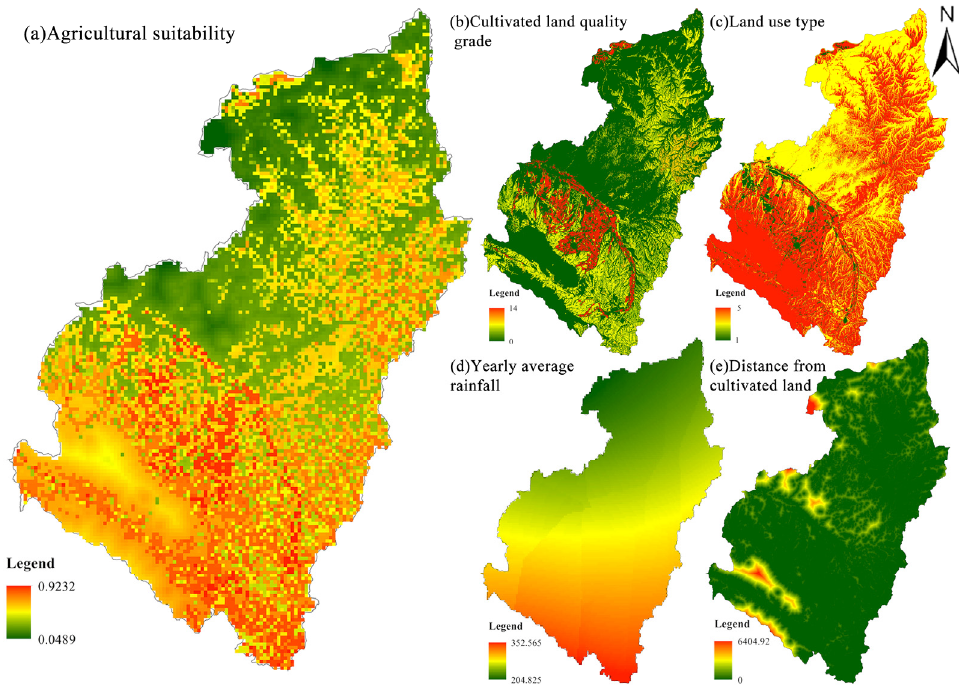
Figure 7. The spatial distribution of the agricultural production suitability.